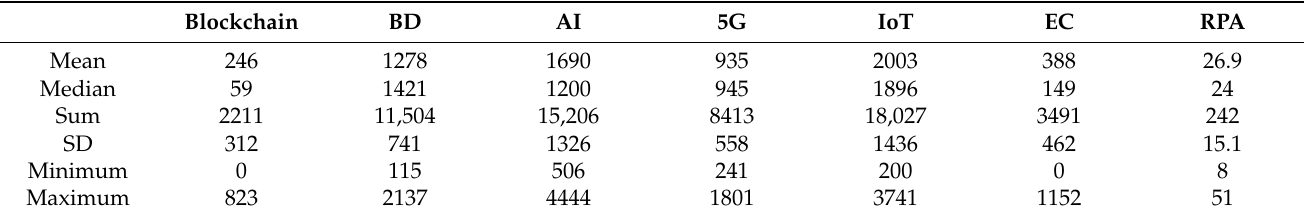
Table 2. The descriptive statistics of publication number on cognitive technologies.